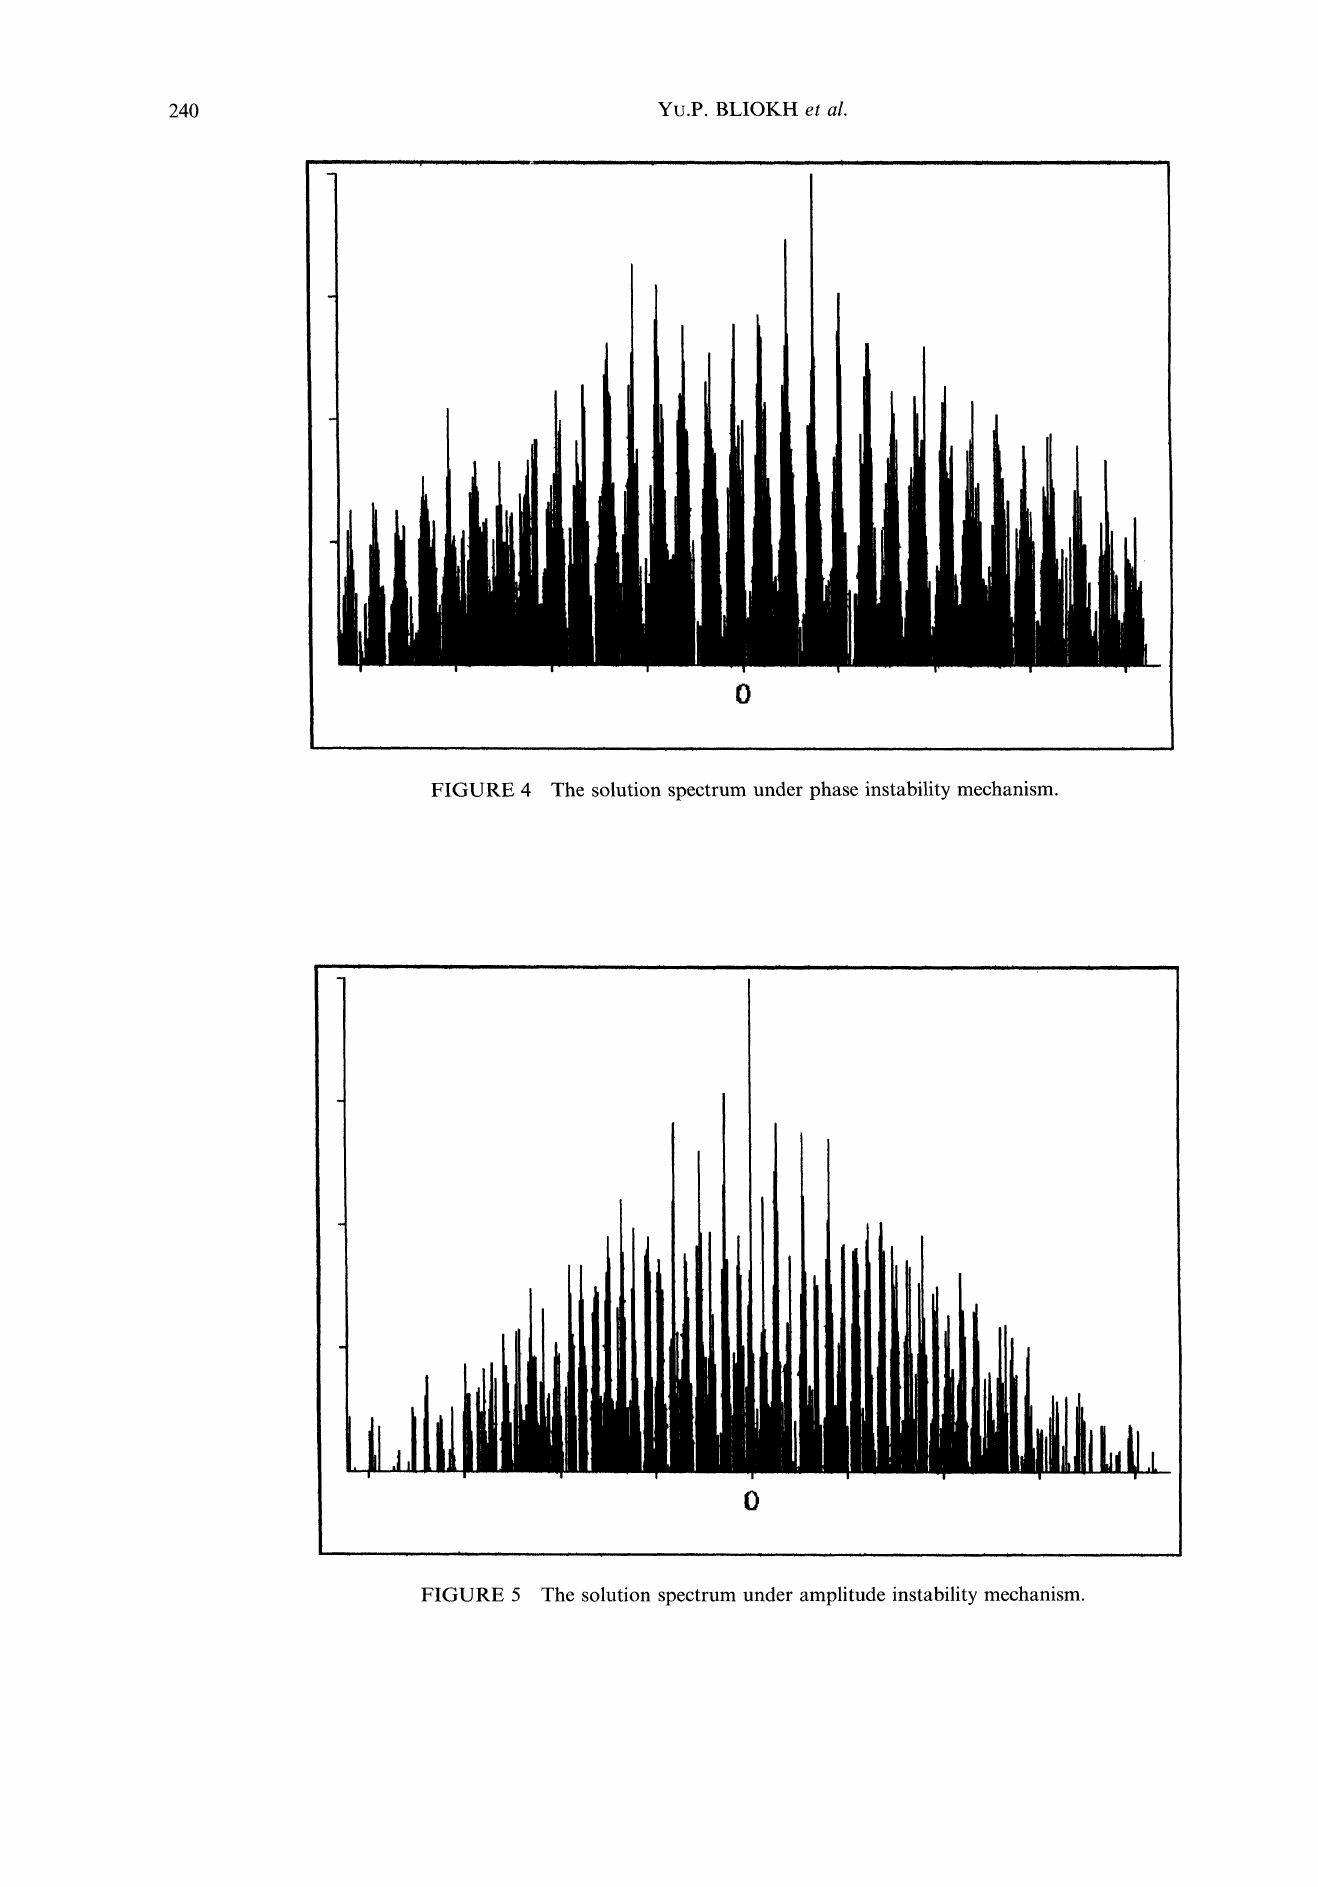
FIGURE 5 The solution spectrum under amplitude instability